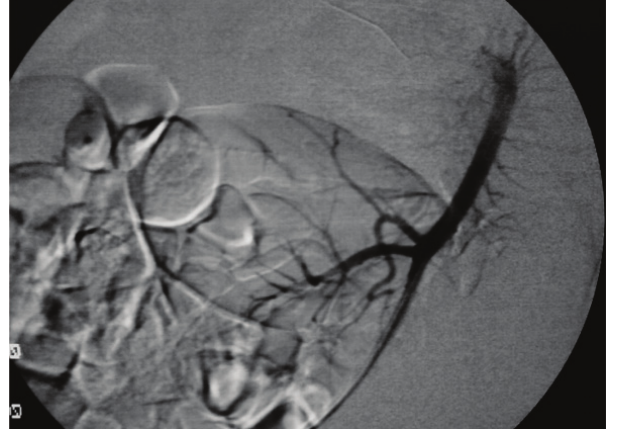
Figure 1 - Thoracoabdominal aortography with identification of the celiac trunk and hepatic, gastroduodenal, and superior mesenteric arteries of the smaller twin